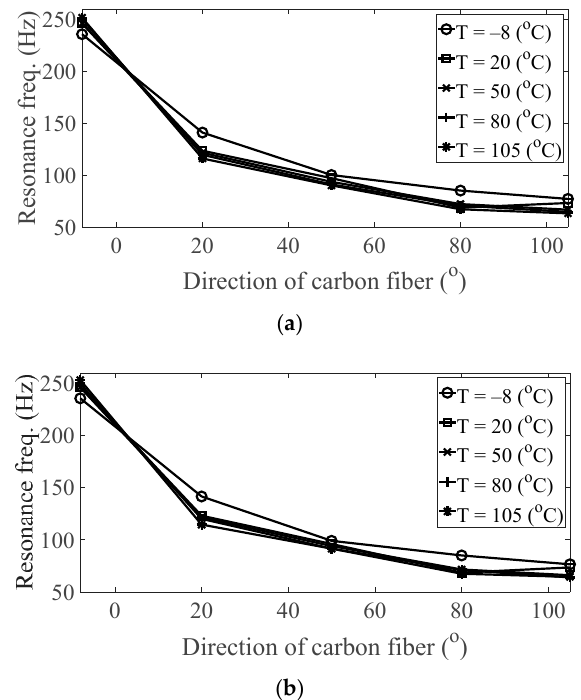
Figure 12. Variation of resonance frequency ( ω n ,1 ) according to different directions of carbon fiber: ( a ) p = harmonic and ( b ) p = random. Materials 2019 , 12 , x